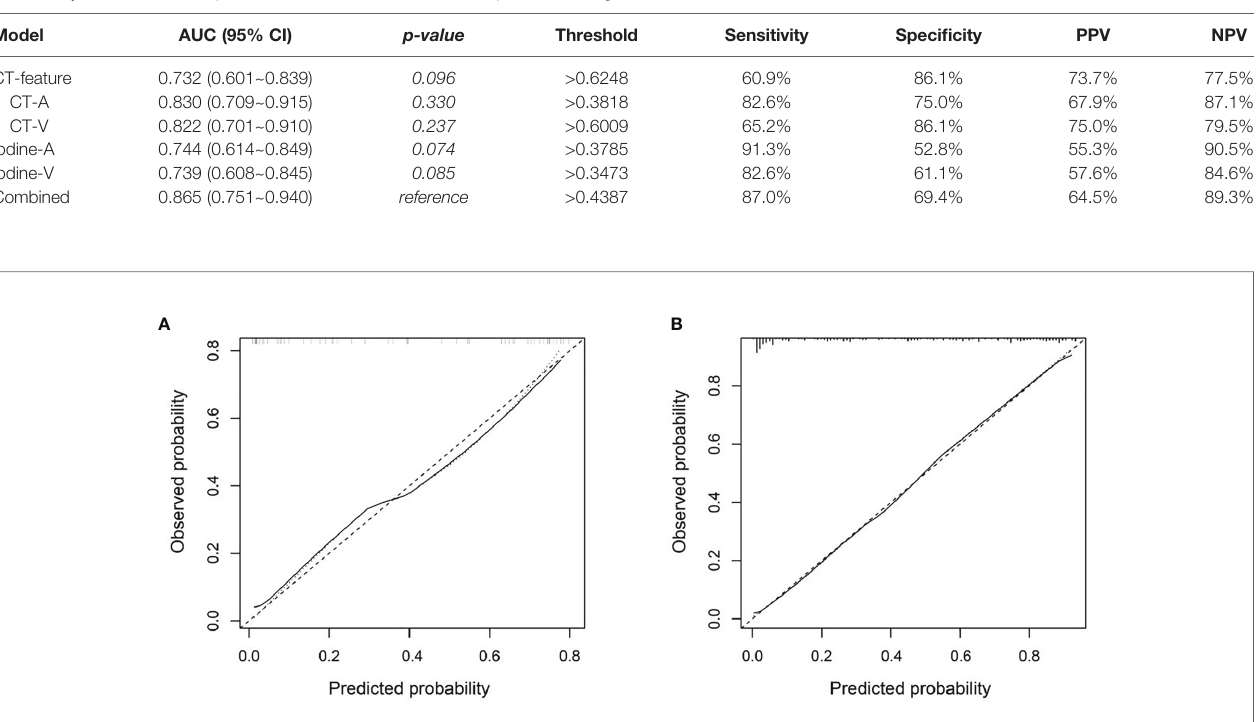
FIGURE 5 | Calibration curve of the Combined model in the development set (A) and the independent testing set (B) . The X axis and Y axis represent the predicted lymph nodes metastasis probability and the actual metastasis rate, respectively. A closer fi t to the diagonal gray dash line represents a better